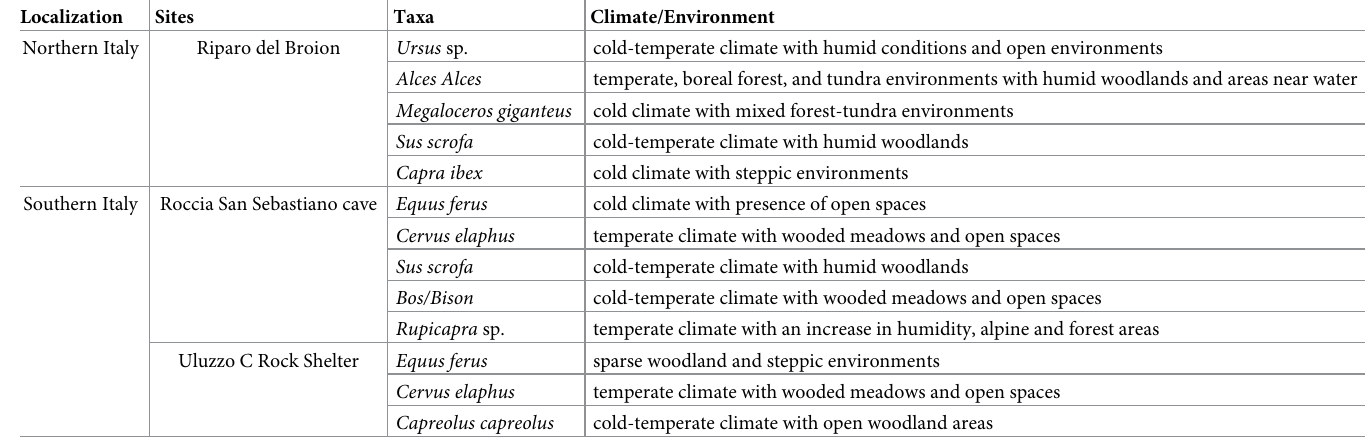
Table 3. Sites under analysis with reference to the dominant taxa and to the most represented environmental and climate setting.